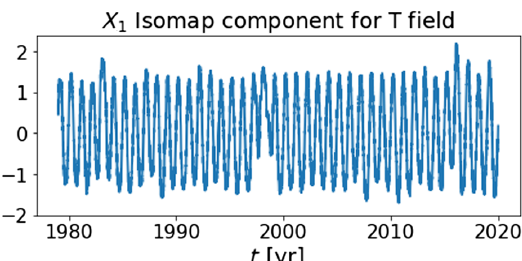
FIG. 17. First Isomap component of temperature anomalies in the ERA5 dataset.